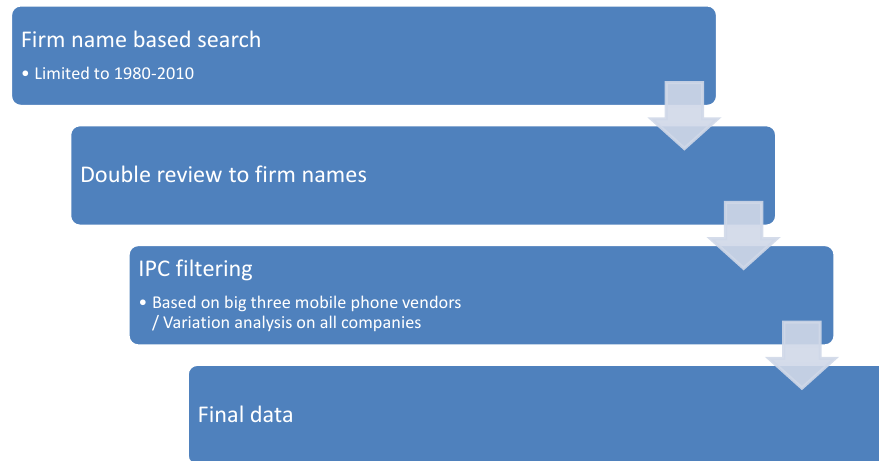
Fig. 1 . Data development